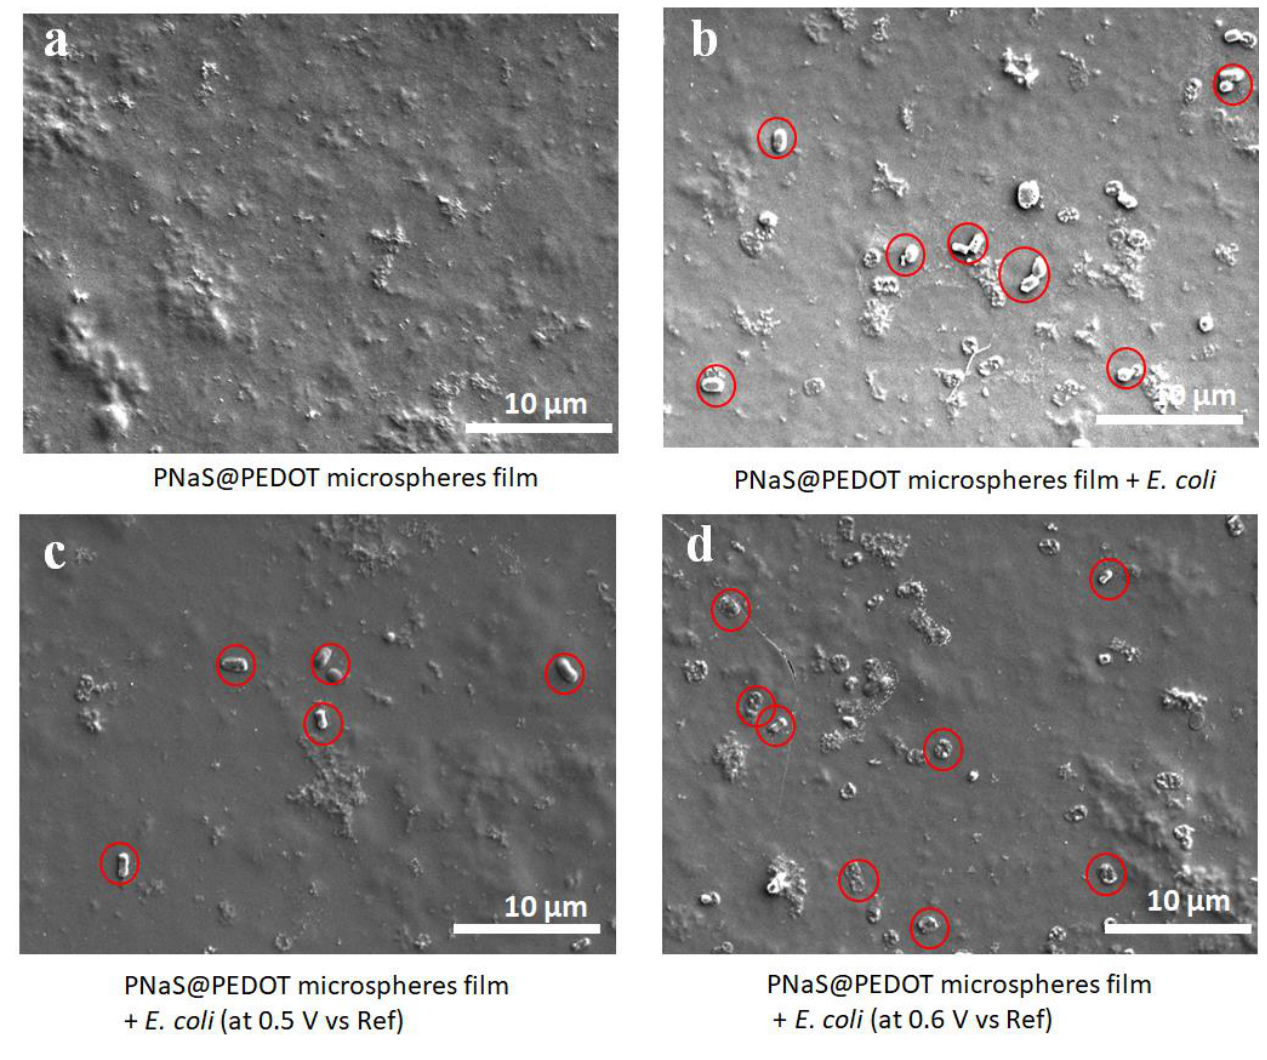
Figure 7. SEM images of PNaSS@PEDOT microsphere film ( a ), PNaSS@PEDOT microsphere film with E. coli ( b ), PNaSS@PEDOT microsphere film with E. coli oxidized at 0.5 V vs. Ag/AgCl ( c ), PNaSS@PEDOT microsphere film with E. coli oxidized at 0.6 V vs. Ag/AgCl ( d ).